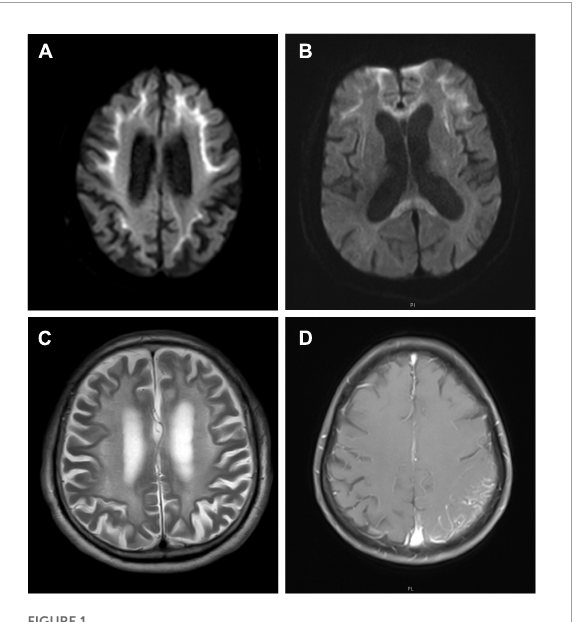
FIGURE1 Cerebral magnetic resonance imaging (MRI) features of neuronal intranuclear inclusion disease (NIID) patients. Diffusion weighted imaging (DWI) showed curve-like hyperintensity along the corticomedullary junction (A) ; DWI also showed lesions in the corpus callosum (B) ; T2-weighted showed symmetrical white matter lesions (C) ; Contrast T1-weighted showed the left temporal occipital cortical edema with enhancement (D) .